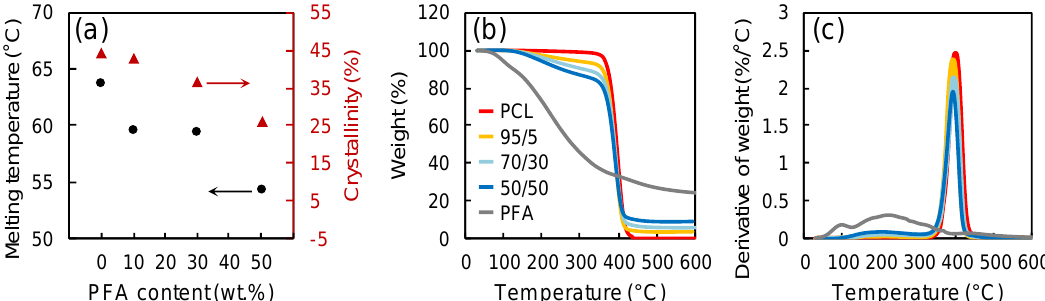
Figure 3. ( a ) Melting temperature and percent crystallinity for PCL and di ff erent PCL / PFA blends measured by DSC and XRD, respectively. Mass loss curves ( b ) and derivatives of each curve ( c ) for PFA, PCL and di ff erent PCL / PFA blends measured by TGA.